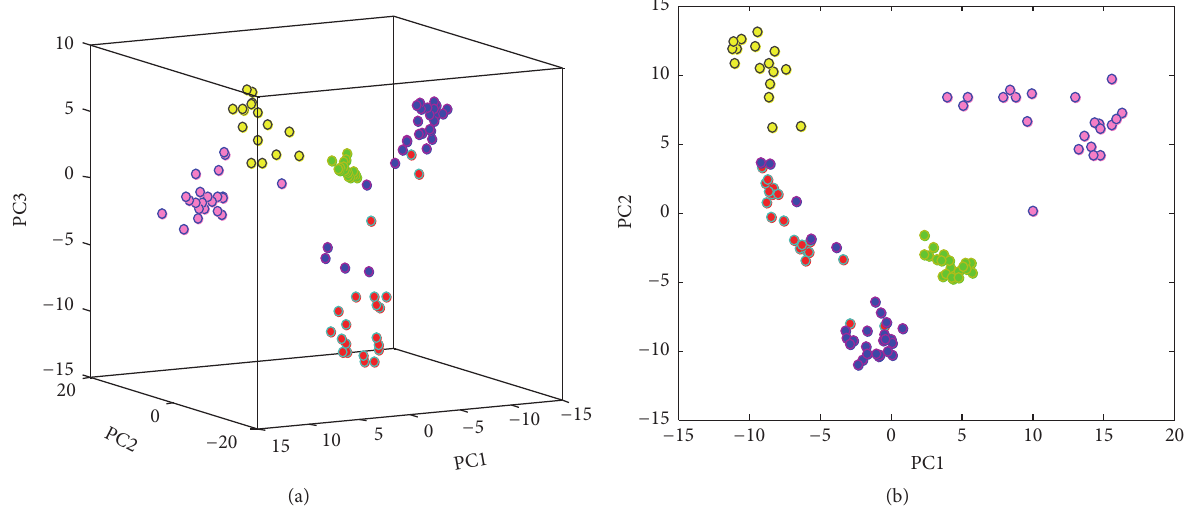
Figure 4: Score plot of PC1, PC2, and PC3 (a). The samples are separated along the three PCs in five clusters: untreated parchment sample (red), the parchment sample treated with castor oil (blue), the parchment sample treated with glycerol (green), the castor oil standard (yellow), and the glycerol standard (pink). (b) represents the score plot of PC1 and PC2.